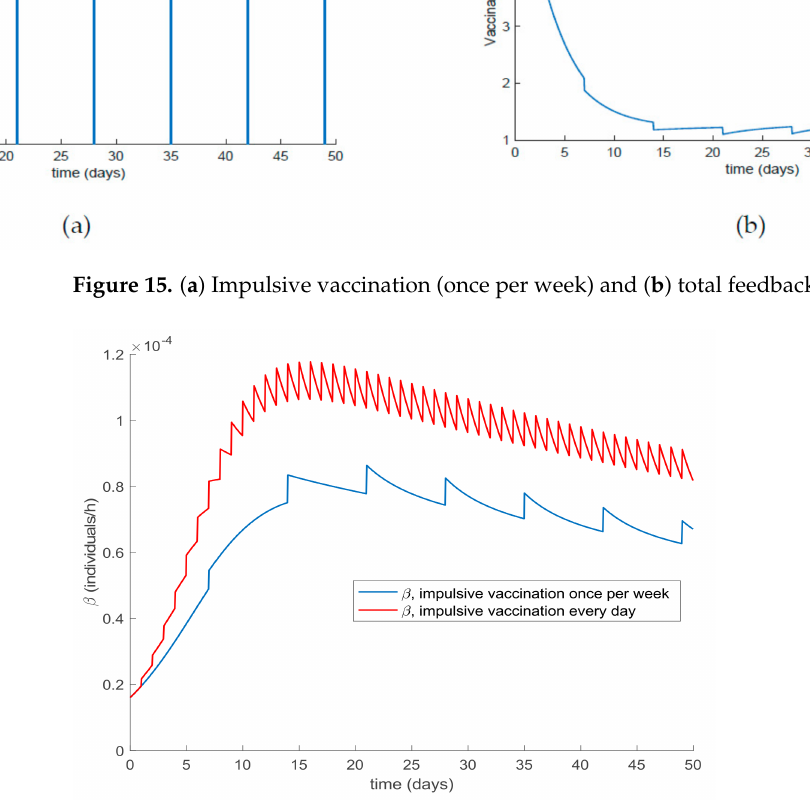
Figure 16. Value of β obtained through (30) when the impulsive vaccination is applied once per week and every